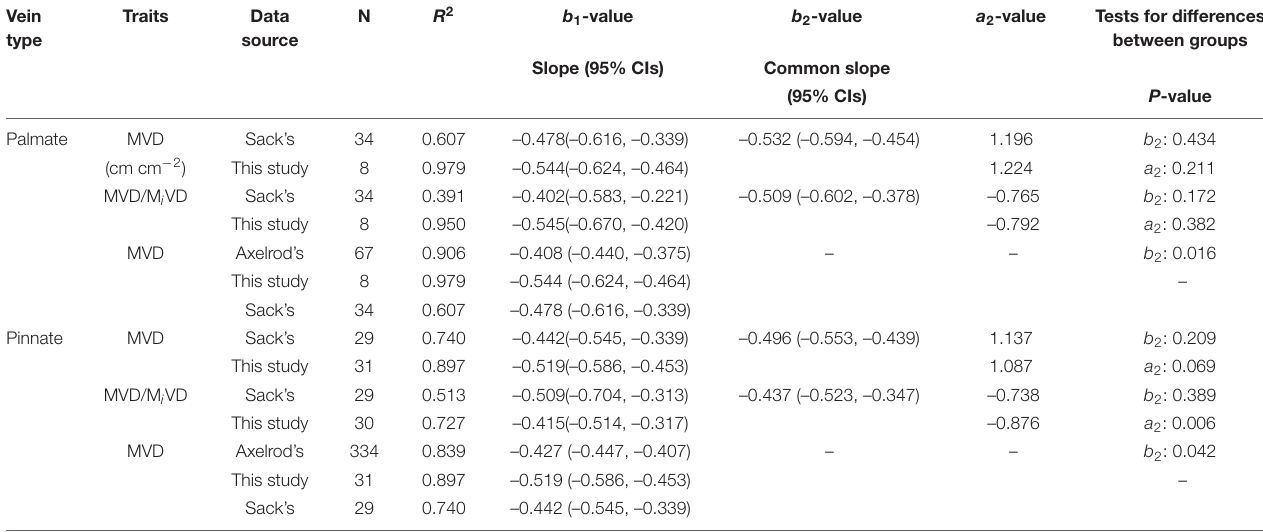
TABLE 3 | Parameters for the scaling of vein traits with leaf size analyzed by OLS method in this study, Sack’s data, and Axelrod’s data (Sack et al., 2012).